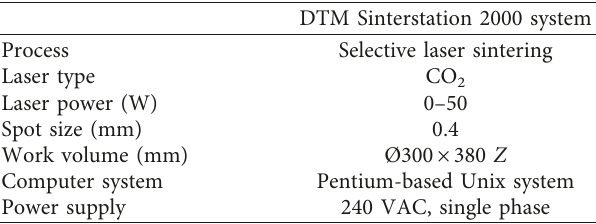
Table 2: Specifications of the “DTM Sinterstation 2000” machine